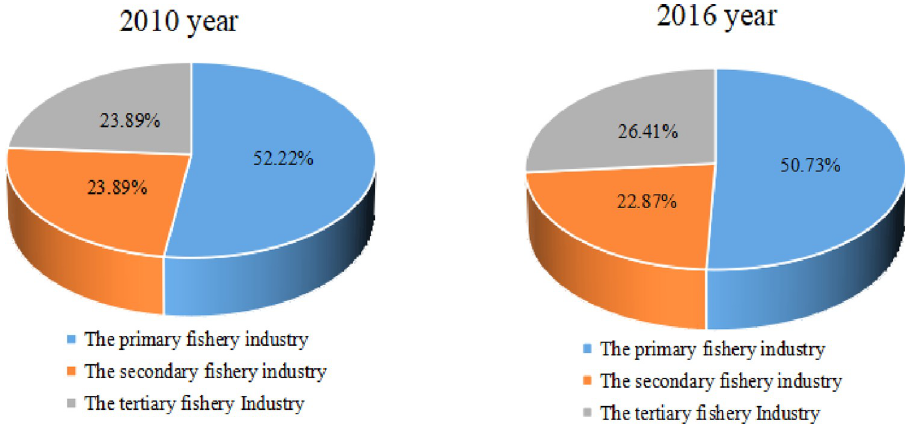
Fig 3. The proportion of the three types of industry structure in China (2010,